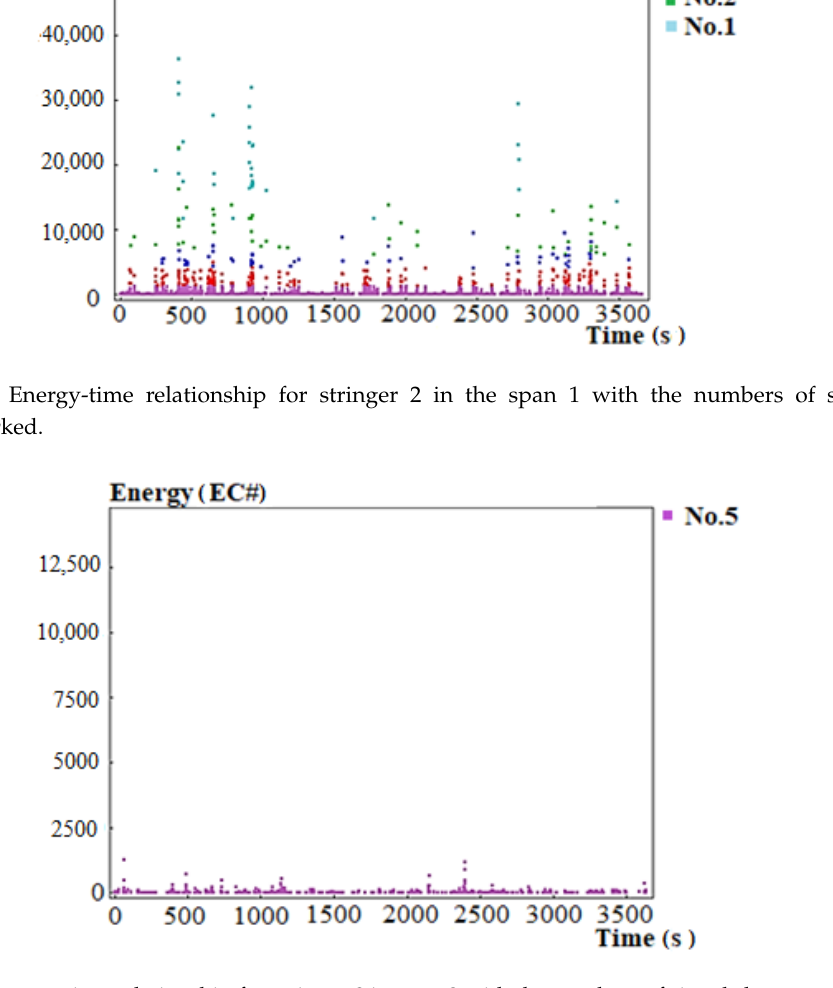
Figure 9. Energy–time relationship for stringer 8 in span 2 with the numbers of signal classes marked.